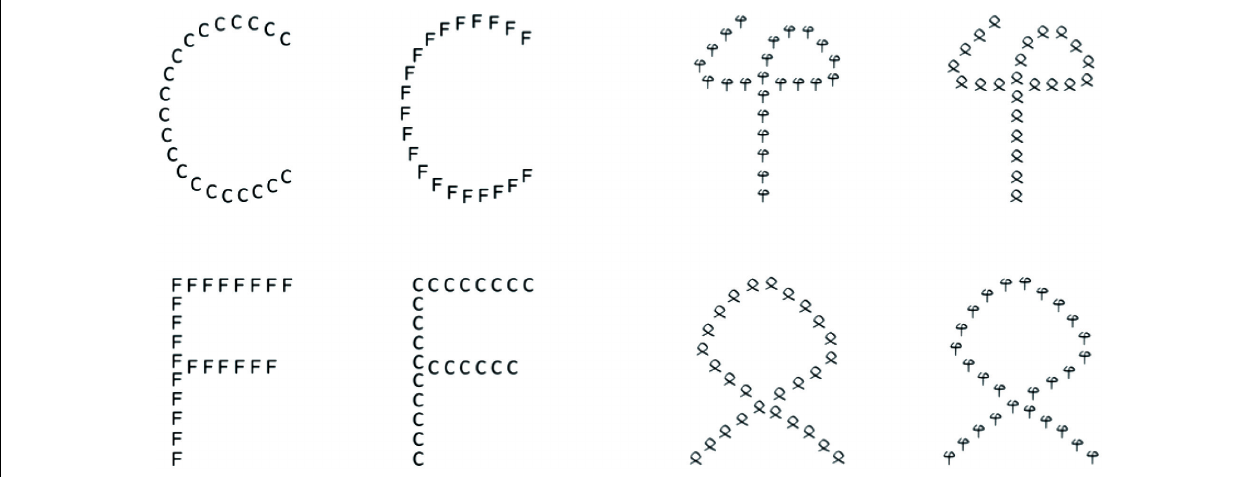
or F, respectively. Second column: incongruent letter stimuli, i.e., the global-level letters differ from the local level ones.Third column: congruent non-letter stimuli; right most column: incongruent non-letter